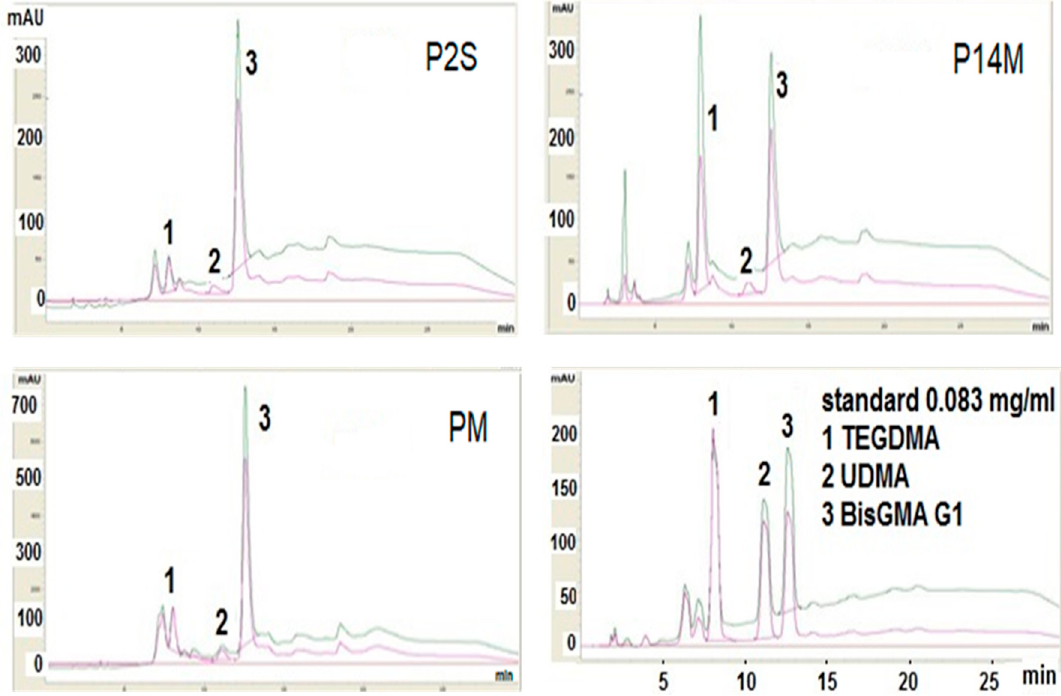
Figure 3. HPLC chromatograms of standards monomers solutions (BisGMA, TEGDMA, UDMA) and representative chromatograms of the extracted monomers in chloroform.